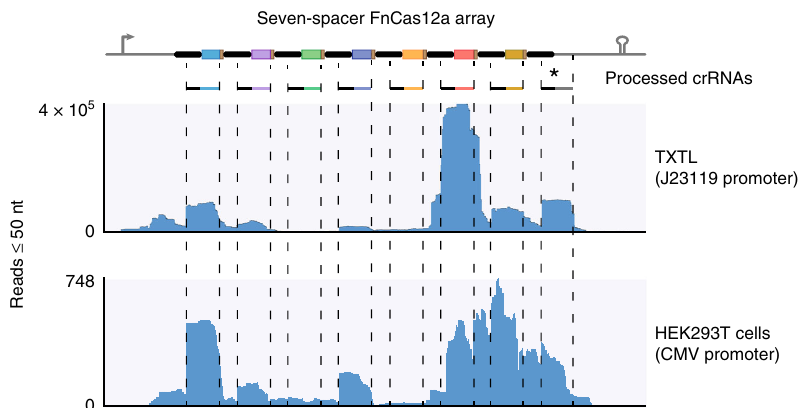
Fig. 5 RNA-seq analysis revealed ranging crRNA abundances and an extraneous crRNA. RNA-seq analysis of the seven-spacer array from Fig. 1c co- expressed with FnCas12a in TXTL (top) or in HEK293T cells (bottom). The assembled array and FnCas12a were expressed followed by small-RNA isolation and RNA-seq analysis. Reads of no more than 50 nts were mapped to the expression construct for the synthetic FnCas12a array with seven spacers. The asterisk indicates the extraneous crRNA derived from the terminal repeat. For the experiments in HEK293T cells, the array was expressed from a